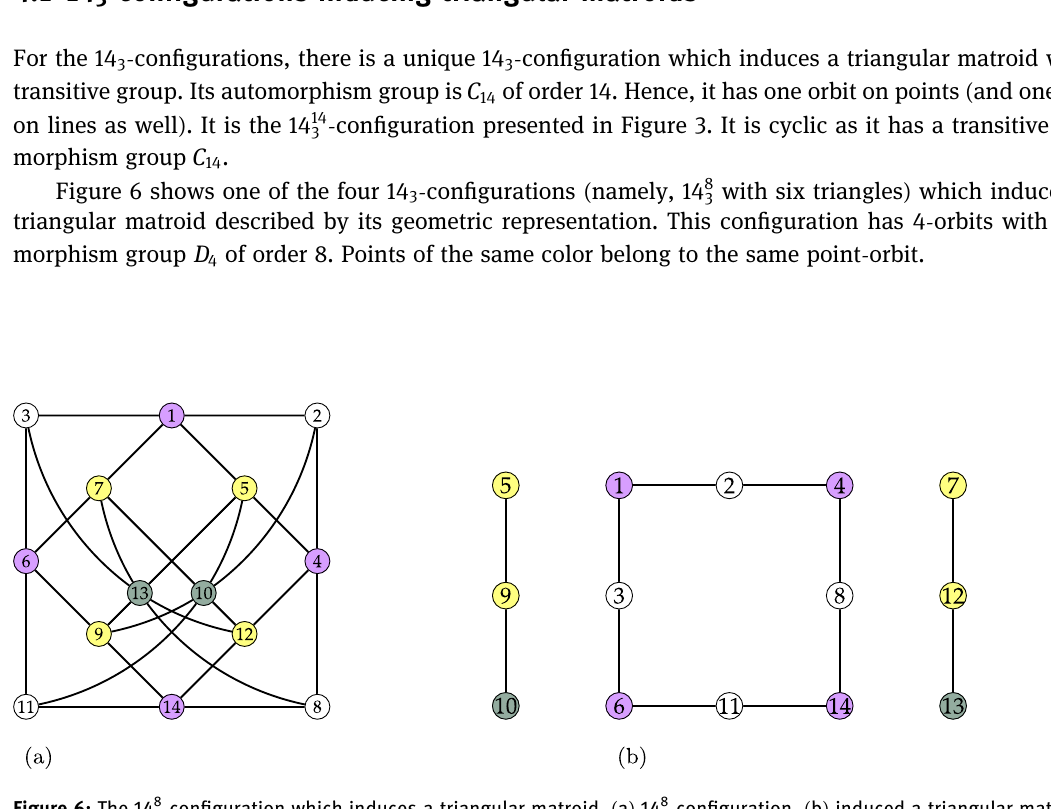
Figure 6: The 14 38 - con fi guration which induces a triangular matroid. ( a ) 14 38 - con fi guration, ( b ) induced a triangular